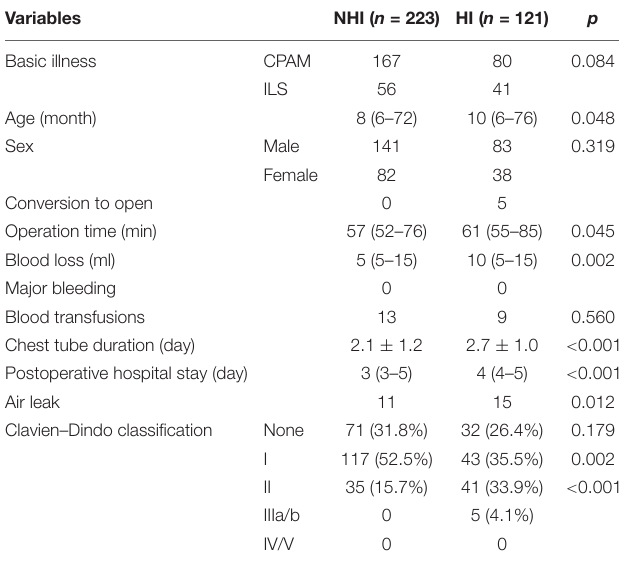
TABLE 3 | Characteristics of asymptomatic patients with CPAM or ILS who underwent thoracoscopic lobectomy.